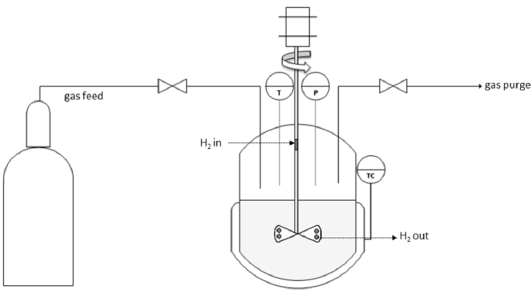
Figure 10. Schematic diagram of the experimental device used for the experiments: Autoclave picture is available in the Supplementary Material.